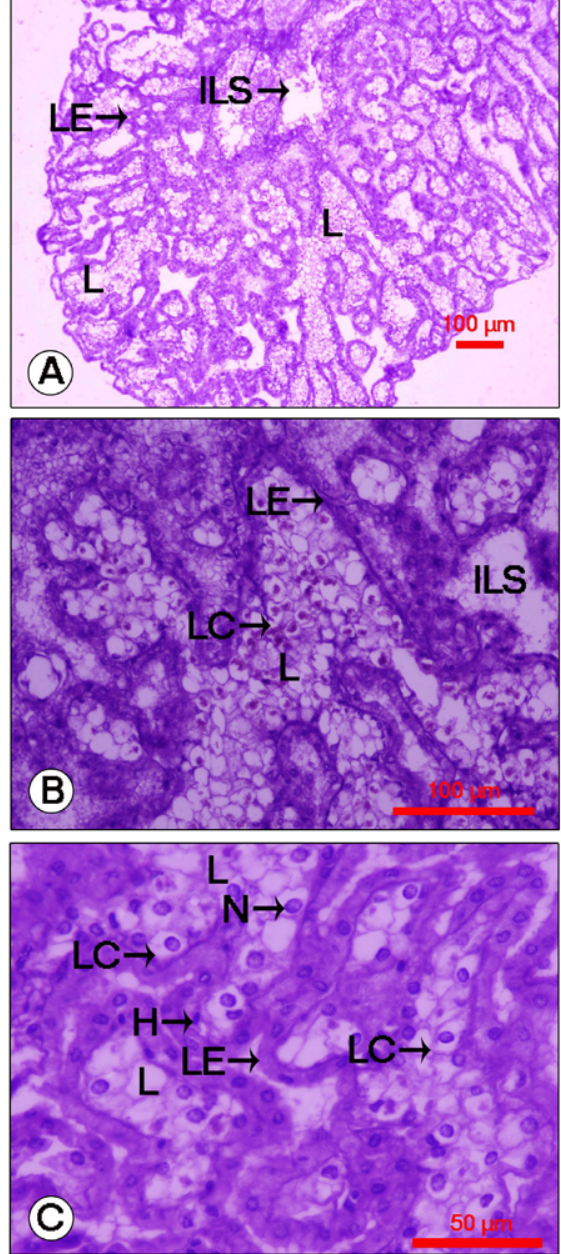
Figure 5. Light micrograph of Y-organ of control crabs during C4 stage in Travancoriana schirnerae. ( A ) Closely packed lobules with reduced inter-lobular spaces. ( B ) Large, branched lobules with closely arranged gland cells. ( C ) Enlarged view of lobules with compactly packed larger cells. H: Hemocyte; ILS: Inter-lobular space; L: Lobule; LC: Larger cell; LE: Lobular epithelium; N: